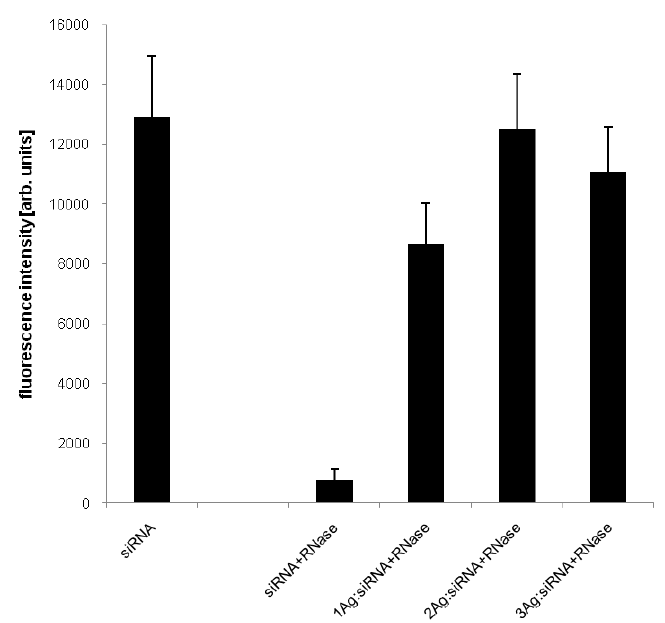
Figure 3. Protective effect of AgNPs towards siRNA (siBcl-xl) treated with RNase. ( A ) The first lane demonstrates migration of non-complexed siRNA. The third lane shows migration of siRNA incubated with RNase A/T1 (10 µg/mL) for 30 min at 37 °C. The following lanes show the migration of siRNA released from complexes with AgNPs, indicating the protection of siRNA from enzymatic cleavage. ( B ) Quantification (by computer image analysis using ImageJ software) of bands in the gel. Data presented as the percentage of band intensity, mean ± SD, n = 3.